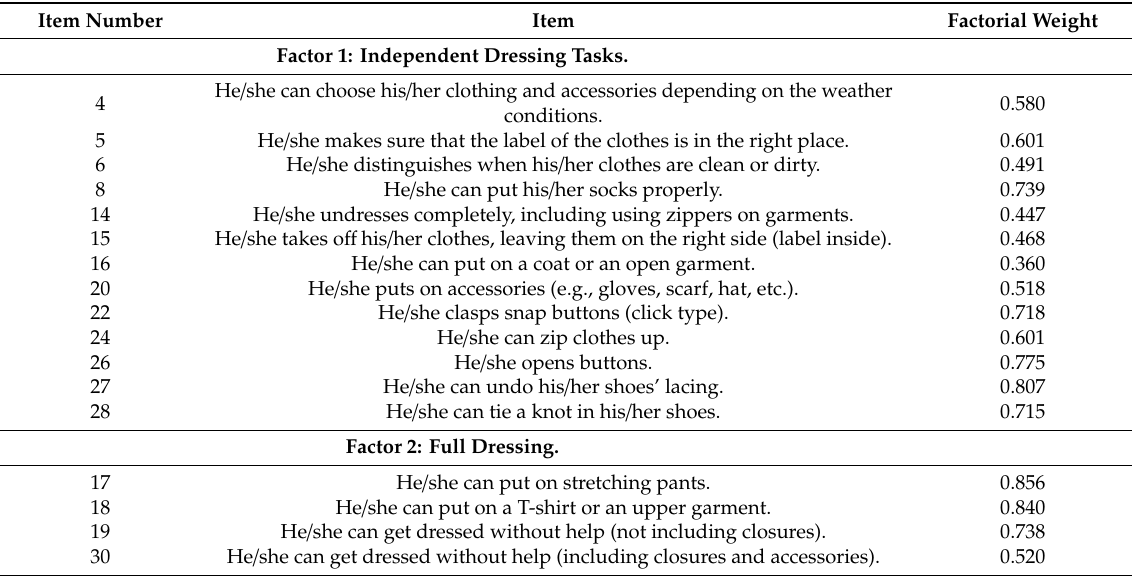
Table 9. Getting Dressed scale factorial